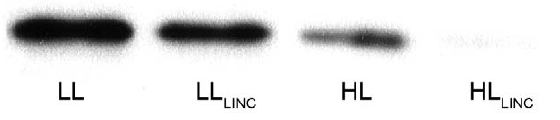
Figure 1. Immunodetection of the PSII reaction centre protein D1 in Phaeodactylumtricornutum . Treatments (1 h duration): LL (low light, 40 m mol photons m 2 2 s 2 1 ); HL (high light, 1,250 m mol photons m 2 2 s 2 1 ); LL LINC (low light with LINC); and HL LINC (high light with LINC).